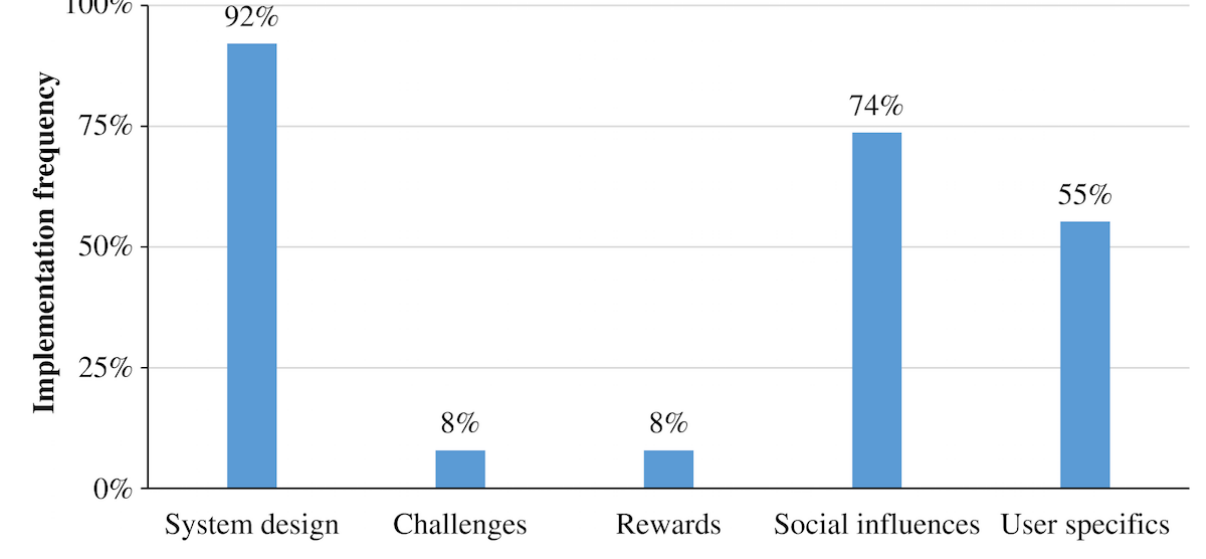
Figure 4. Percentage of apps which applied at least one component fully from the corresponding gamification component